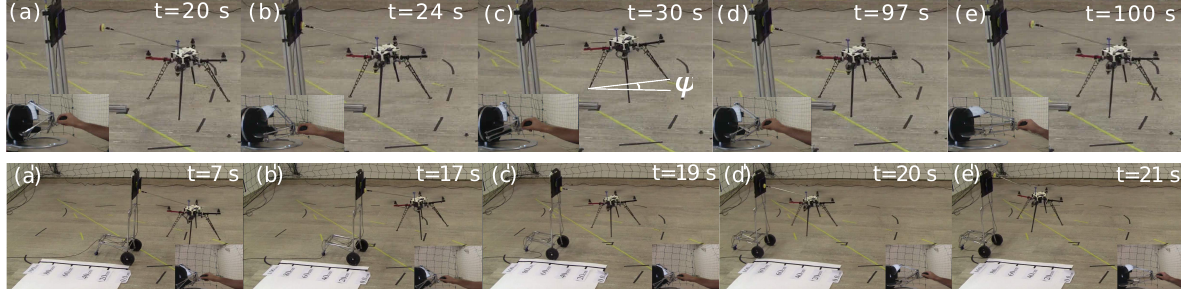
Figure 7. Snapshots of stationary object ( top ) and movable object ( bottom ) experiments. The experiments aimed to dock and apply a commanded time-varying force to the objects. ( a , a’ ) In free flight, ( b , b’ ) establishing a contact with the object, ( c , c’ ) applying force vectors, ( d , d’ ) releasing the contact, and ( e , e’ ) in free flight